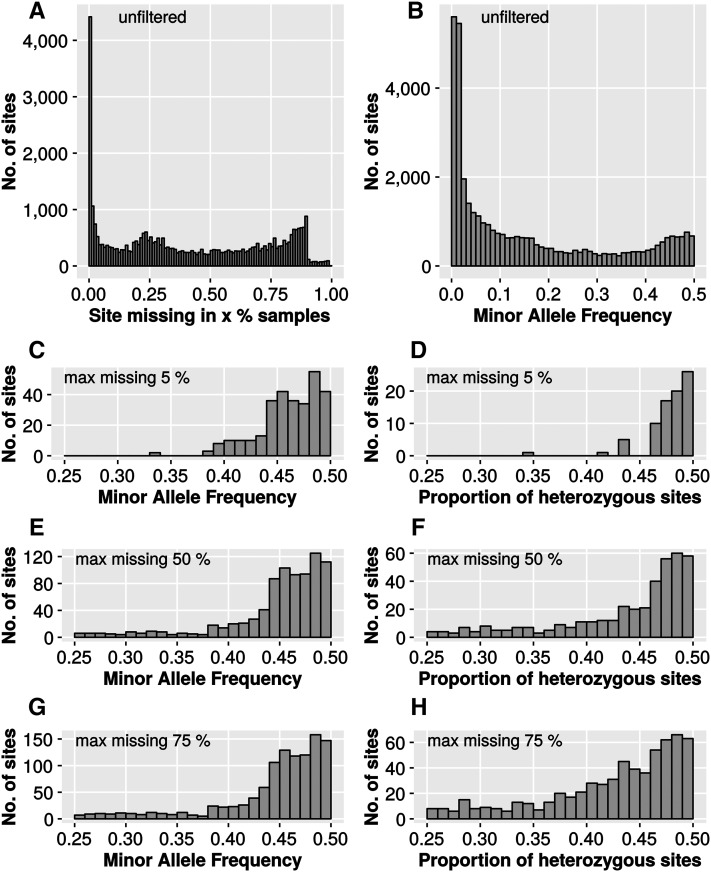
Basic SNP characteristics using different filter settings for missing data. Shown are histograms representing the number of SNP sites that exhibit a certain sample coverage (A), minor allele frequency (B, C, E, and G), or proportion of heterozygous sites (D, F, and H). Data are from 813 F2 plants from the fall 2014 population, and were generated using the TASSEL 4 site report function. For (A) and (B), unfiltered data directly after SNP calling was used. For (C)–(H), SNP sites were filtered by the indicated proportion of missing data per sample, but no further data imputation or error correction was performed.